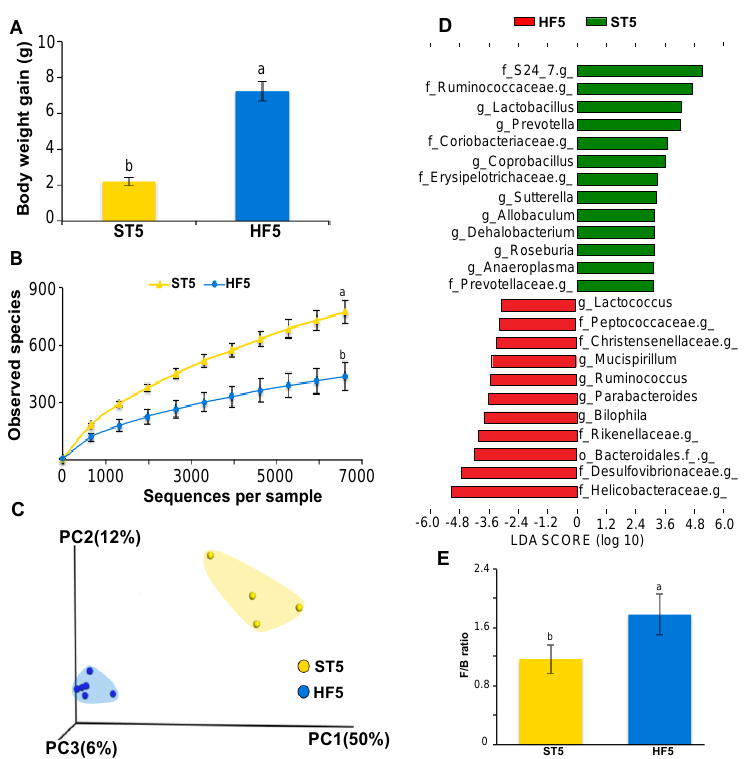
Figure 1. High-fat diet consumption for five weeks induced overweight and modified the cecal microbiota composition of mice. Body weight gain ( A ); bacterial alpha diversity in cecum according to diet ( B ); principal coordinate analysis (PCoA) plot of cecal communities ( C ); linear discriminant analysis showing the differentially-overrepresented genera between mice fed with standard and high-fat diets ( D ); and the effect of the diet on the Firmicutes/Bacteroidetes ratio ( E ). Treatments with different superscript letters indicate significant differences ( t test, p < 0.05).